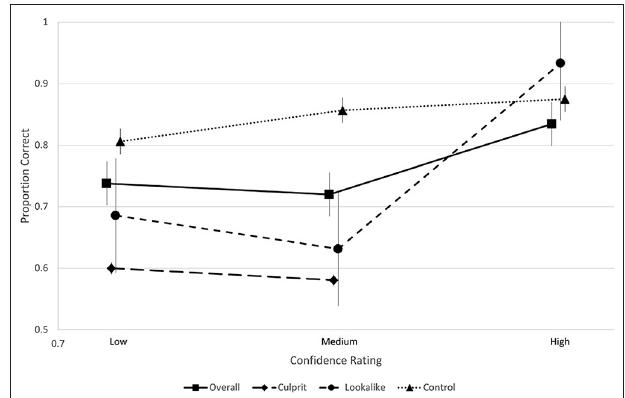
FIGURE 4 | CAC analysis overall and by